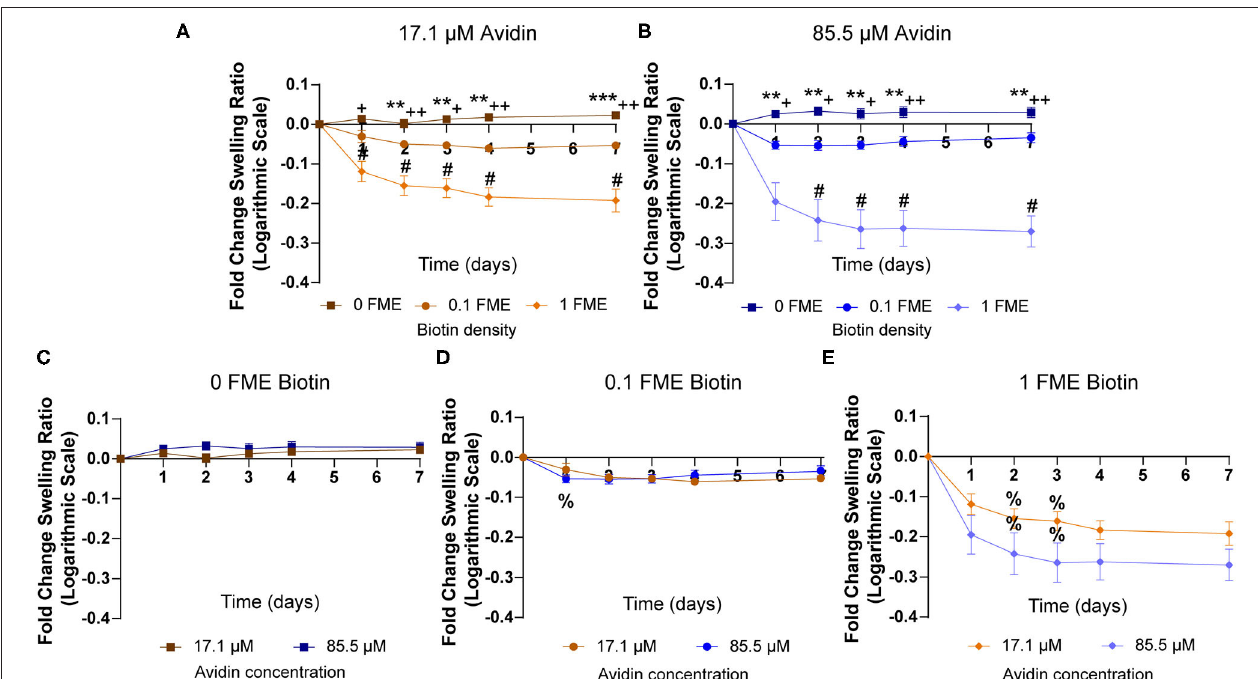
FIGURE 3 | Effects of biotin concentration on swelling properties in avidin swelling buffer. (A,B) Fold changes in swelling ratios compared to day 0 time point of hydrogels biotinylated with 0, 0.1, or 1 FME NHS-dPEG 12 -biotin in (A) 17.1 µ M avidin or (B) 85.5 µ M avidin for 7 days. n = 3, mean ± SD. Statistical significance between different FME hydrogels determined using two-way ANOVA with Tukey’s post-hoc test (0 FME vs. 0.1 FME: ** p < 0.01, *** p < 0.001; 0 FME vs. 1 FME: + p < 0.05, ++ p < 0.01; 0.1 FME vs. 1 FME: # p < 0.05). (C–E) Fold changes in swelling ratios of hydrogels with (C) 0 FME, (D) 0.1 FME, or (E) 1 FME NHS-dPEG 12 -biotin, in either 17.1 or 85.5 µ M avidin solutions, over 7 days. n = 3, mean ± SD. No statistical significance resulting from different avidin concentrations, determined using two-way ANOVA with Sidak’s post-hoc test. Statistical significance between time points determined using two-way ANOVA with Tukey’s post-hoc test ( % indicates p < 0.05 compared to the previous day).